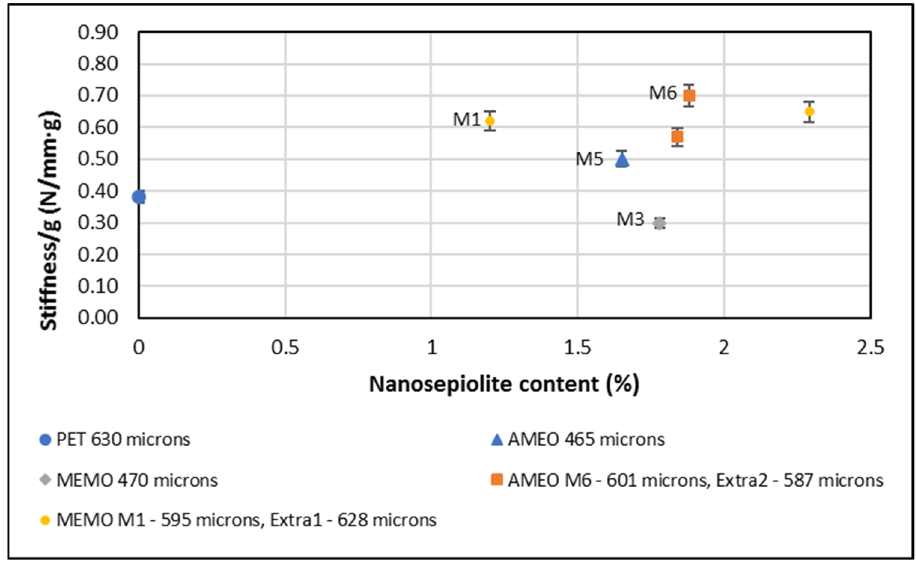
Figure 2. Nanocomposites stiffness per gram compared to that of pure PET.